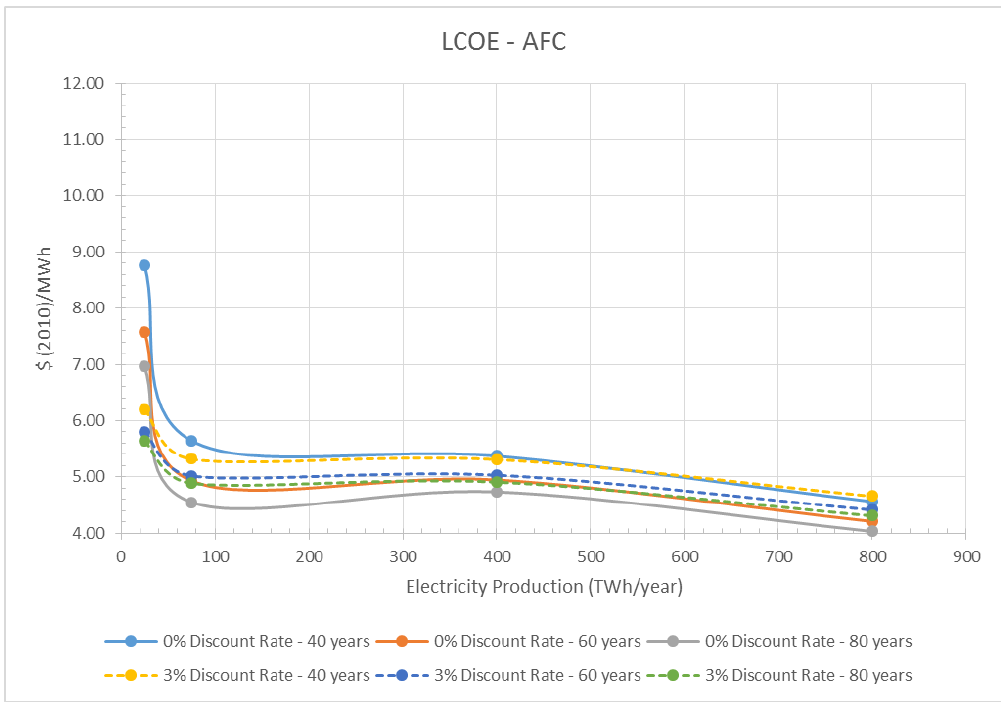
Figure 8. LCOE for AFC.